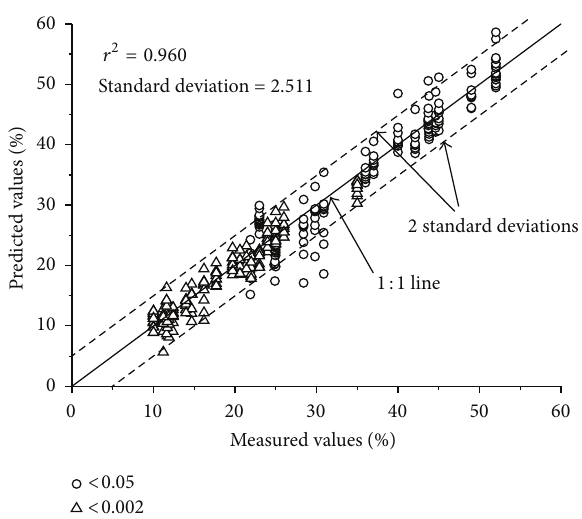
Figure 5: Percentages predicted by one of the eleven PSD models and fractal method versus measured percentages of particles finer than 0.05 mm and 0.002 mm of 20 soils.